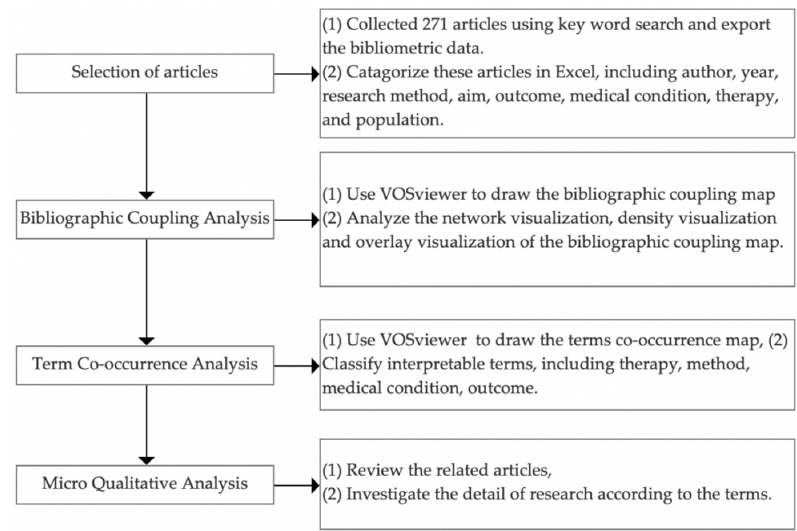
Figure 1. The flow chart of the research methodology.